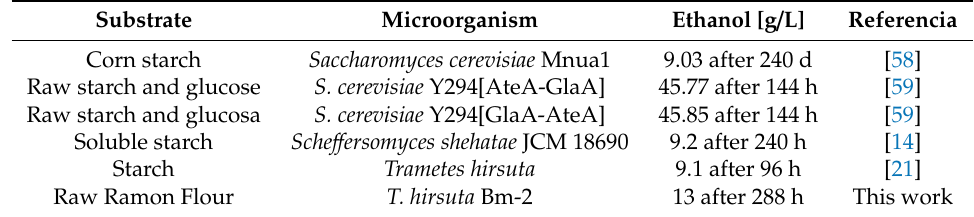
Table 1. Ethanol production through consolidated bioprocessing